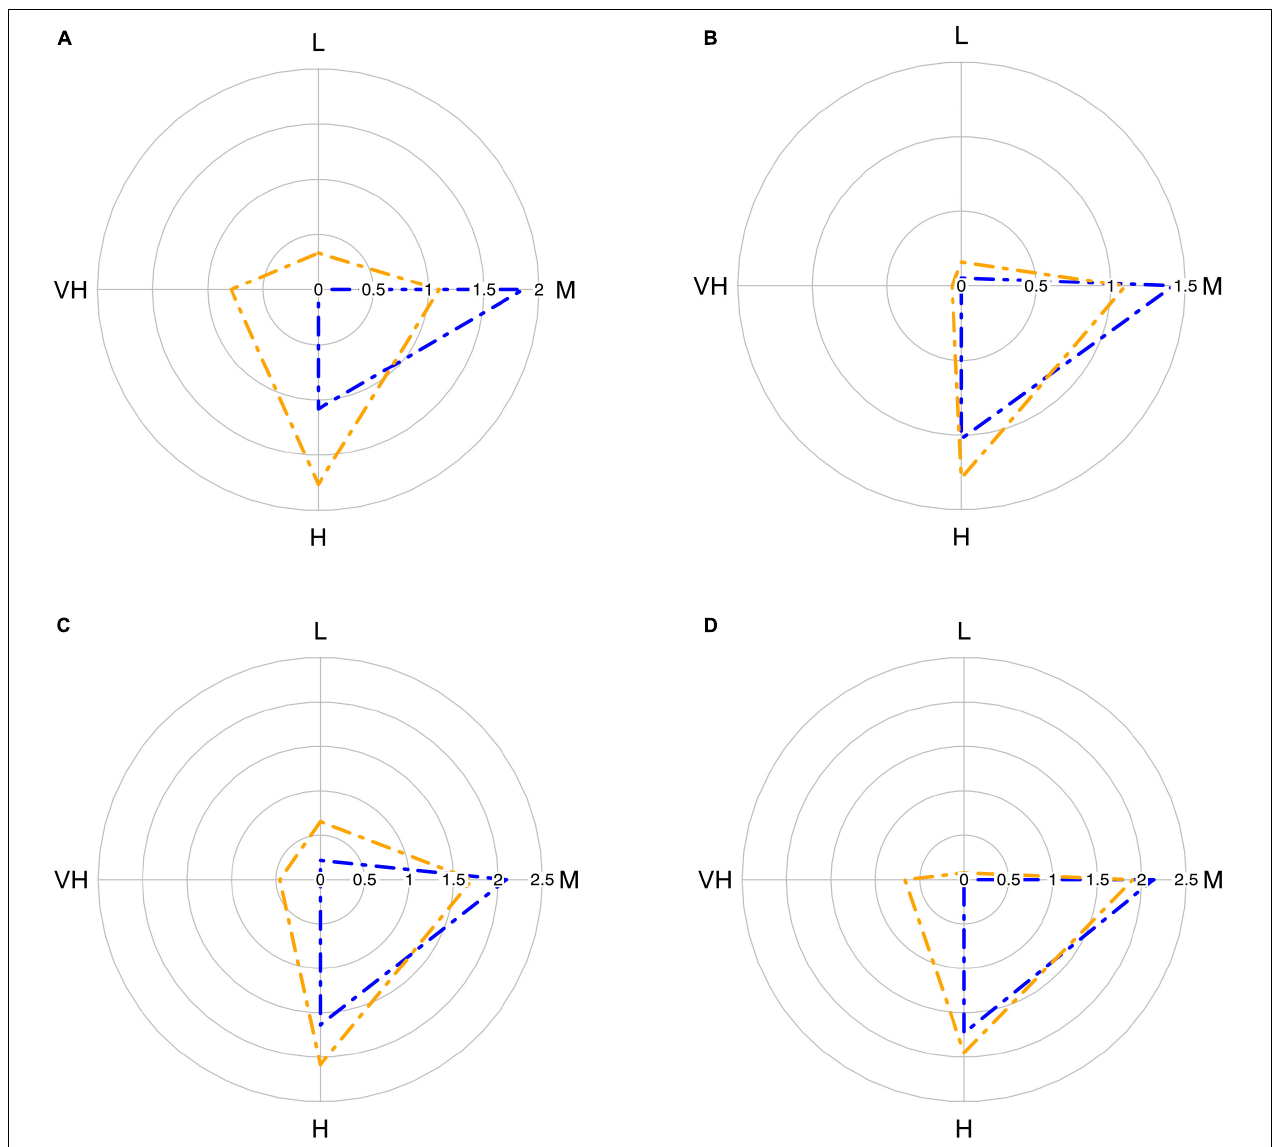
FIGURE 2 | Radar plot with average biomass of the four vulnerability groups in the trawl assemblage in each case study: (A) Algarve; (B) Catalan Sea; (C) Ligurian-North Tyrrhenian Sea; (D) Sicily Strait. Blue polygons correspond to index based in k-means (based on the maximum possible score, 3); orange polygons correspond to index based on natural bins (based on the maximum score recorded in the samples). Vulnerability groups: L, low; M, moderate; H, high; VH, very high. Data: log10 (biomass +